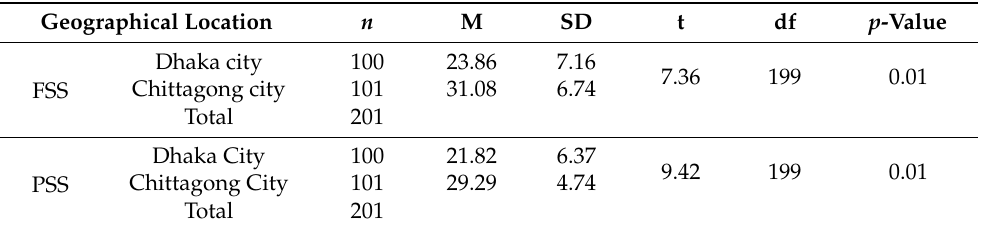
Table 9. Independent sample t -test of fear of sexual crime and personal safety based on geographical location.